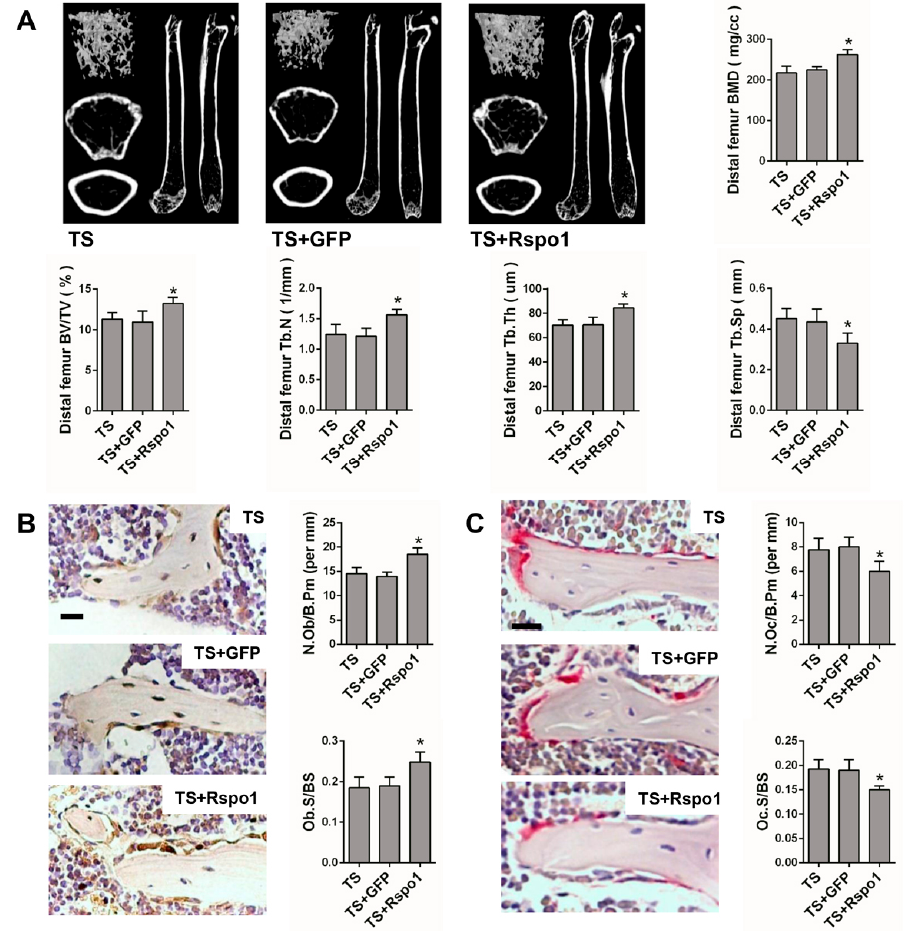
Figure 5. Cont. Figure 5.